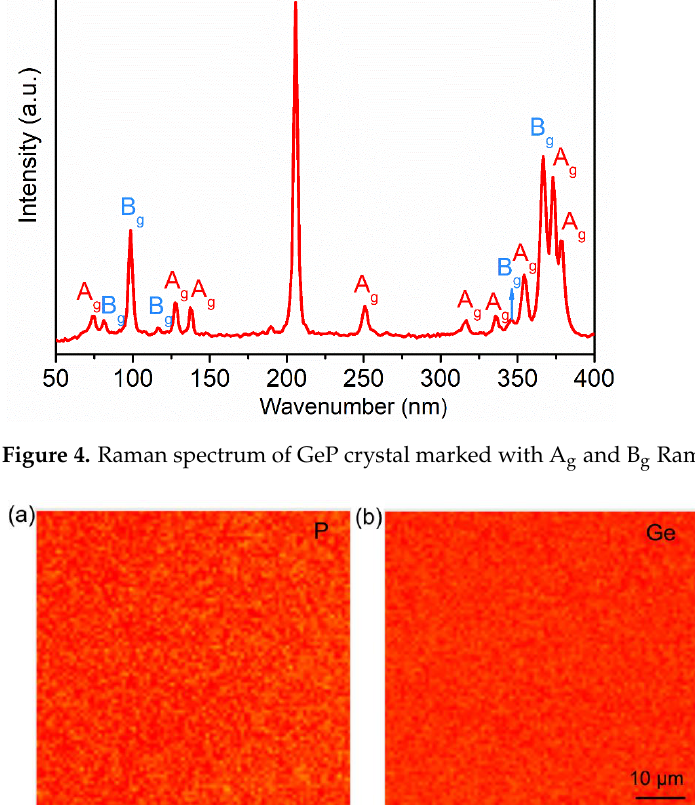
Figure 3. Laue patterns of bulk GeP single crystals grown by Bi flux method at a cooling rate of ( a ) 7 – 10 °C/h, ( b ) 4 – 6 °C/h and ( c ) 1 – 3 °C/h.